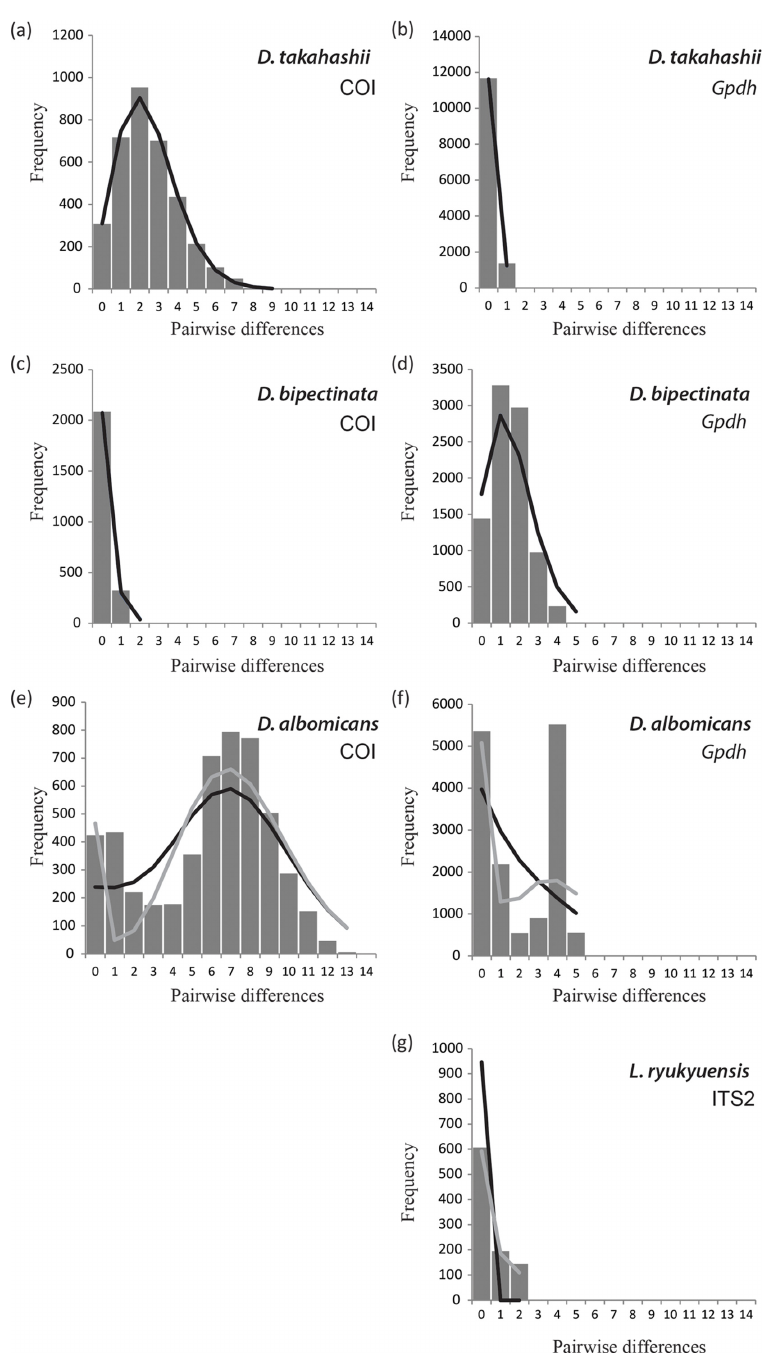
PLOS ONE | DOI:10.1371/journal.pone.0129132 June 12,